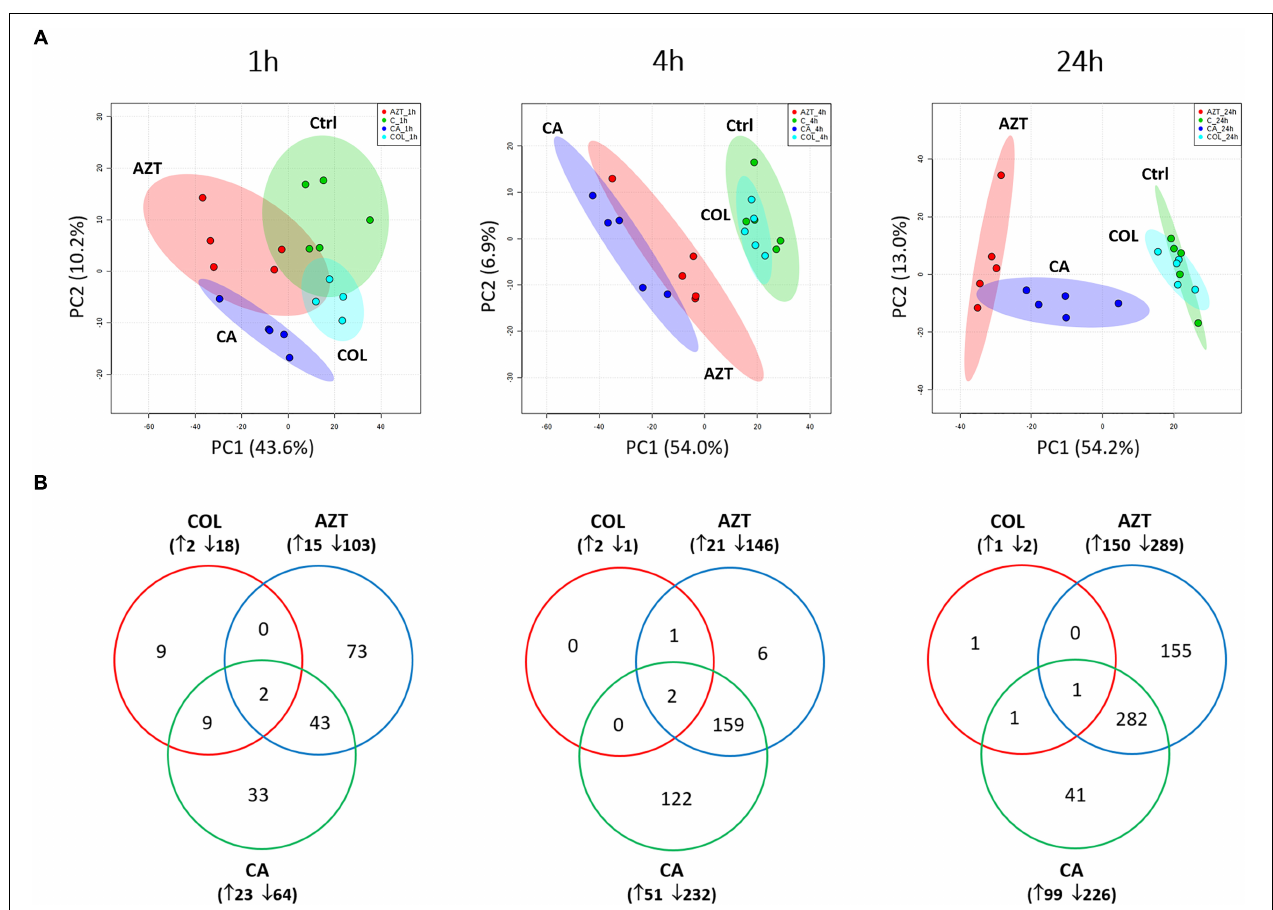
FIGURE 1 | Multivariate and univariate analyses of global metabolic changes. (A) PCA score plots of the first two principle components for metabolite levels in A. baumannii AB090342 after treatments with colistin, aztreonam alone and the combination at 1, 4, and 24 h. Each dataset represents a total of 20 samples of 5 biological replicates under each condition. Green, untreated control (C); cyan, colistin alone (COL); red, aztreonam (AZT) alone; blue, combination (CA). (B) Venn diagrams show the number of significantly affected metabolites by each treatment at 1, 4, and 24 h. Significant metabolites were selected based on FDR < 0.05, p < 0.05 and FC ≥ 2 (one-way